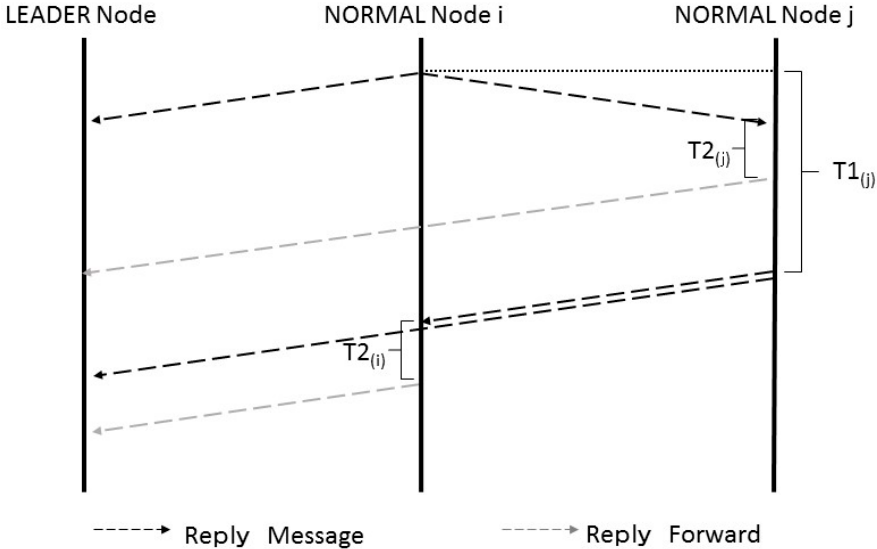
Figure 6. Message transmission sequence of the collision avoidance method using the autonomous response-type protocol.